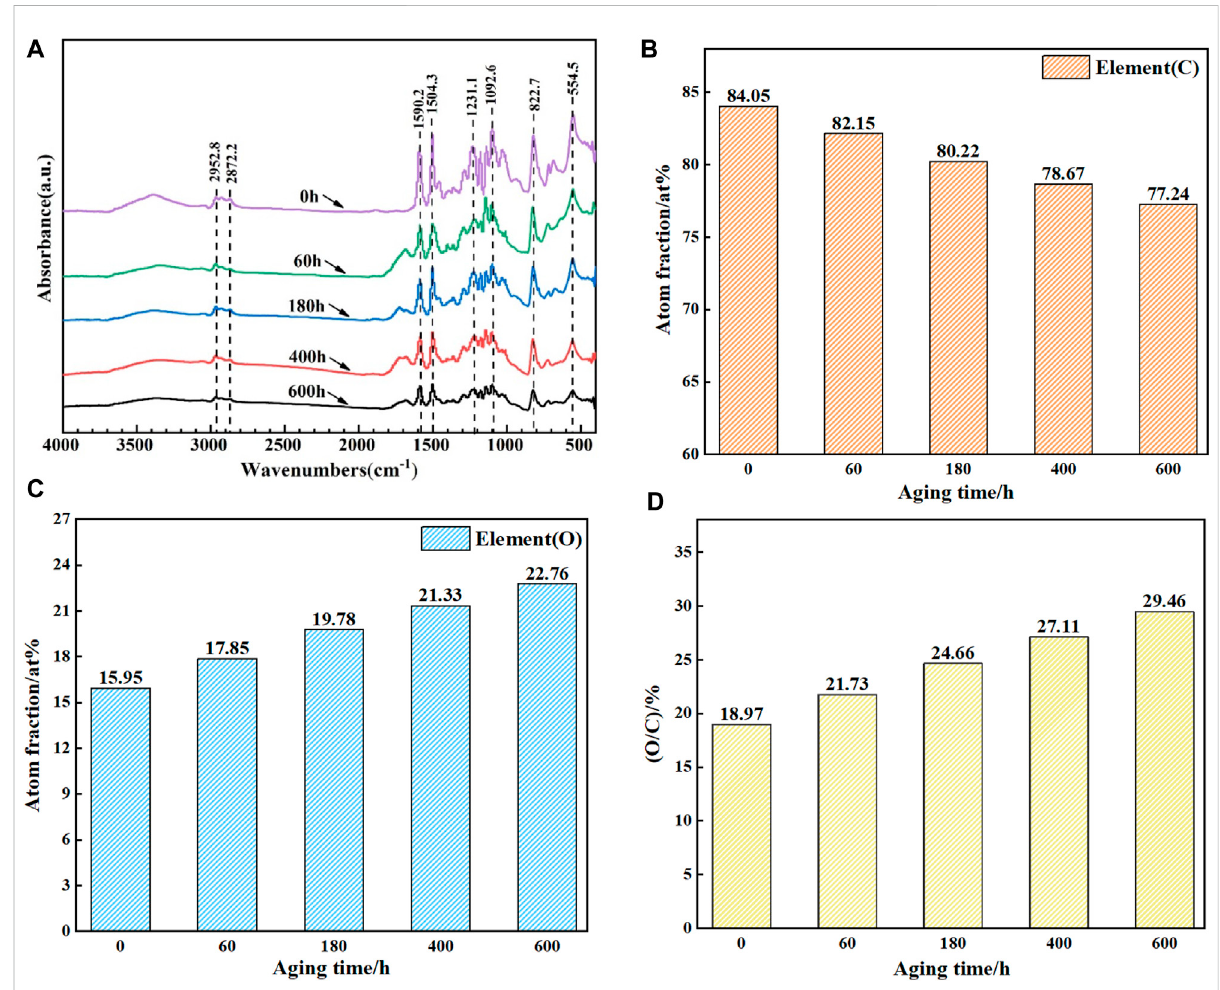
FIGURE 5 (A) FTIRdiagramofepoxyresinwithdifferentagingtime; (B)(C) and (D) aretherelativeatomiccontentofOandCinepoxyresinandthevalueof C/O